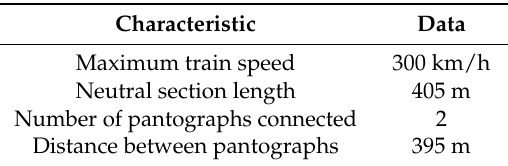
Table 2. Neutral section